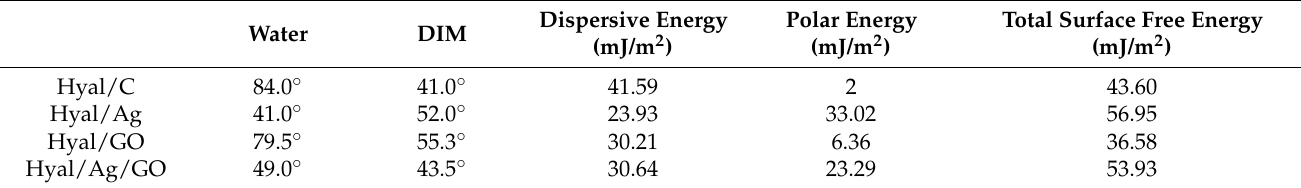
Table 3. The studied foils’ contact angle measured using water and diiodomethane (DIM) and the dispersive, polar and total surface free energies (calculated using the Owen–Wendt